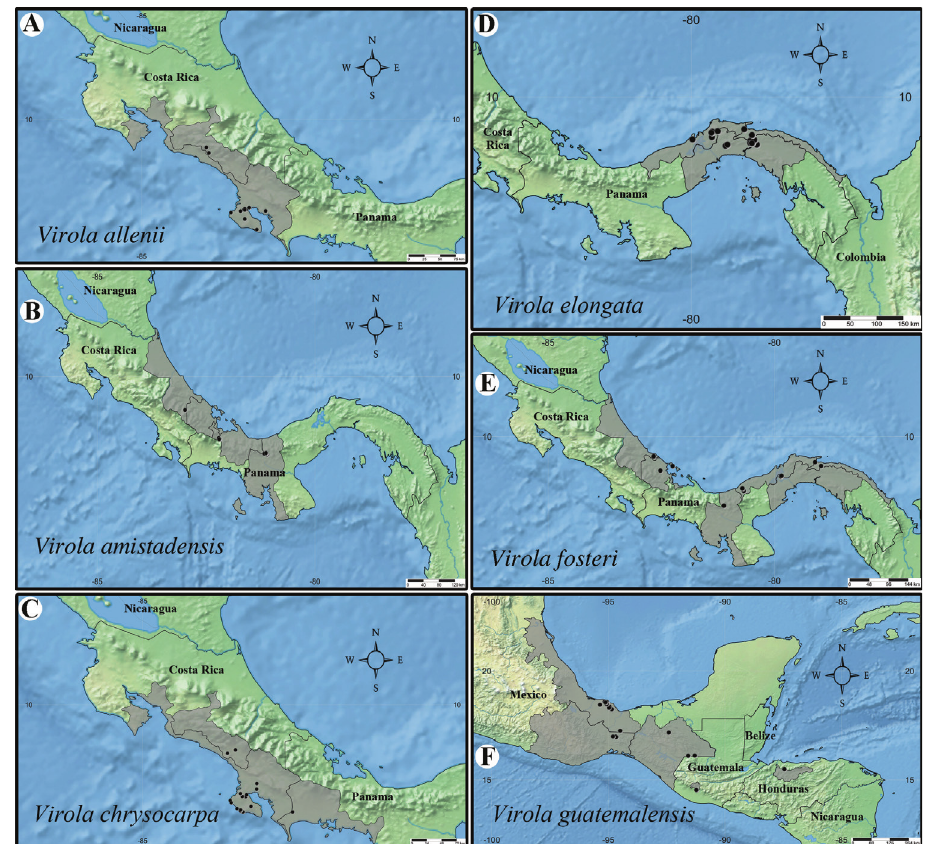
Figure 9. Geographic distribution of Virola allenii ( A ), V. amistadensis ( B ), V. chrysocarpa ( C ), V. elon- gata ( D ), V. fosteri ( E ) and V. guatemalensis ( F